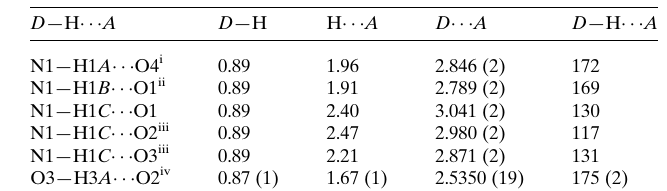
Table 1 Hydrogen-bond geometry (A˚ , (cid:5) ).